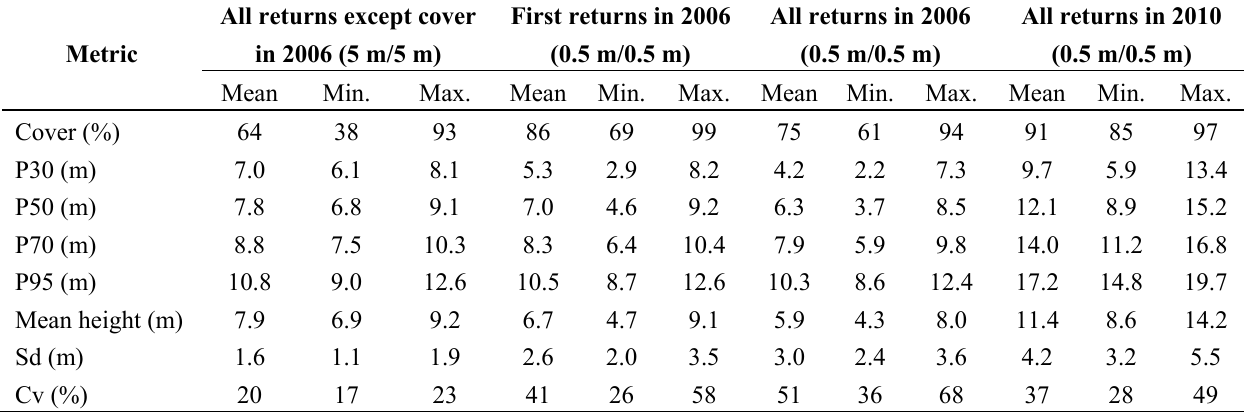
Table 4. Mean and range of various LiDAR metrics (percentile heights, mean height, and dispersion statistics) based on 36 radiata pine plots measured at age 9 (2006) and re-measured at age 13 years (2010) at Puruki Forest. Metrics in 2006 were based on all returns and cover based on first returns with 5 m/5 m as height cut-offs, or first returns and all returns with 0.5 m/0.5 m set as ground/canopy height cut-offs. Metrics in 2010 were based on all returns with 0.5 m/0.5 m set as ground/canopy height